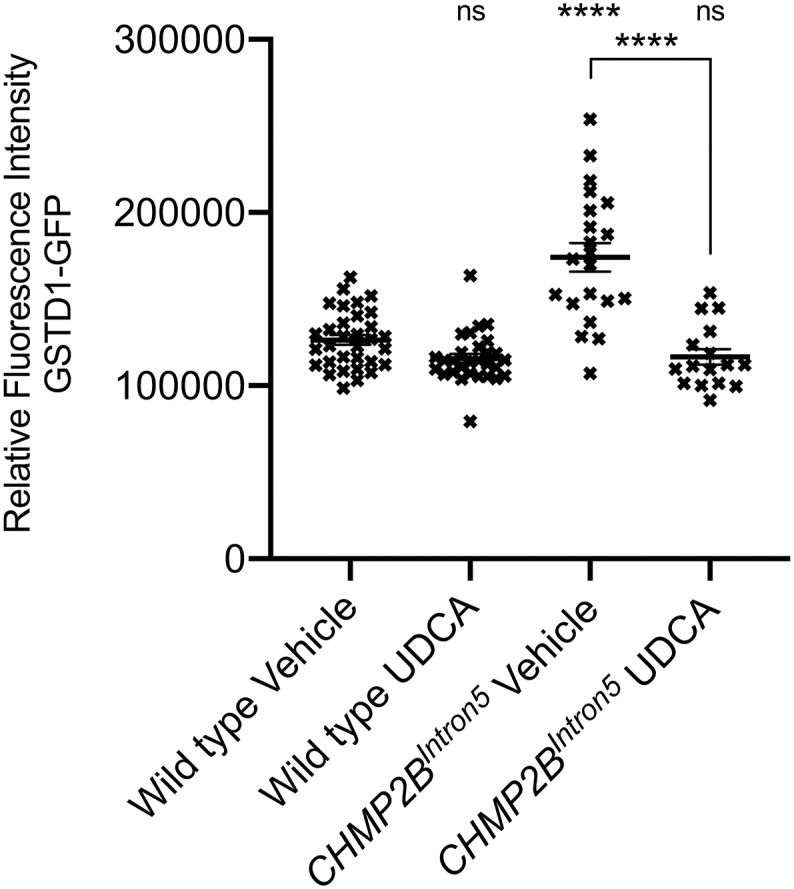
UDCA Rescues Increased Glutathione S-TransferaseD1-GFP Reporter Fluorescence Intensity in CHMP2BIntron5 Expressing Larvae.Quantification of GstD1-GFP reporter expression in wild type and nSyb > CHMP2BIntron5 third instar larvae fed either vehicle or UDCA. ANOVA with Tukey's multiple comparisons post hoc test (⁎⁎⁎⁎p < .0001).